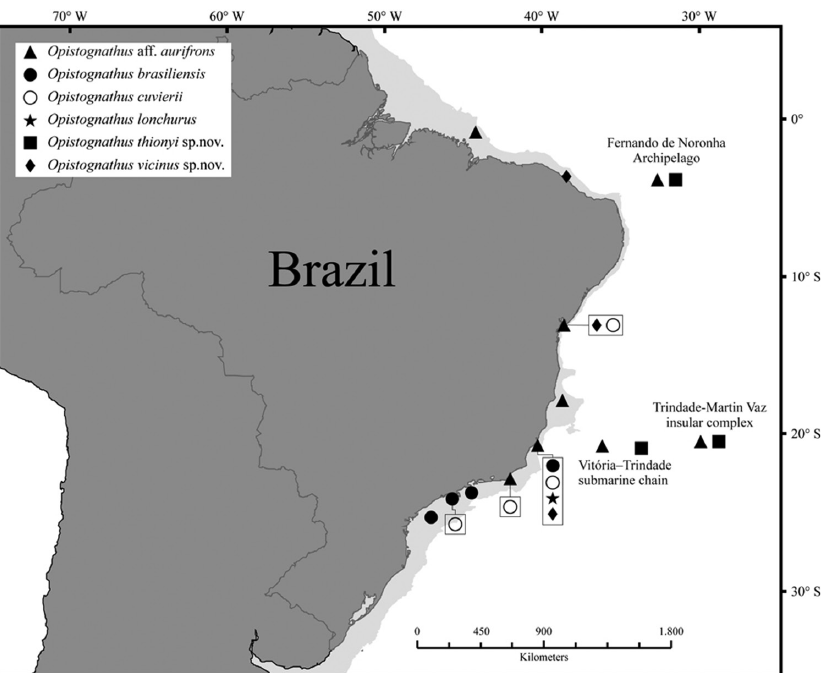
Figure 6. Distributions of Opistognathus species in Brazilian Province; light shaded areas indicate con- tinental shelf.